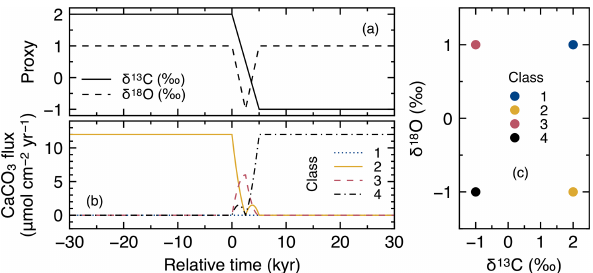
Figure 10. Timelines of proxy inputs (a) and rain fluxes of individ- ual classes of CaCO 3 particles (b) with different proxy values (c) in simulations examining signal distortion by